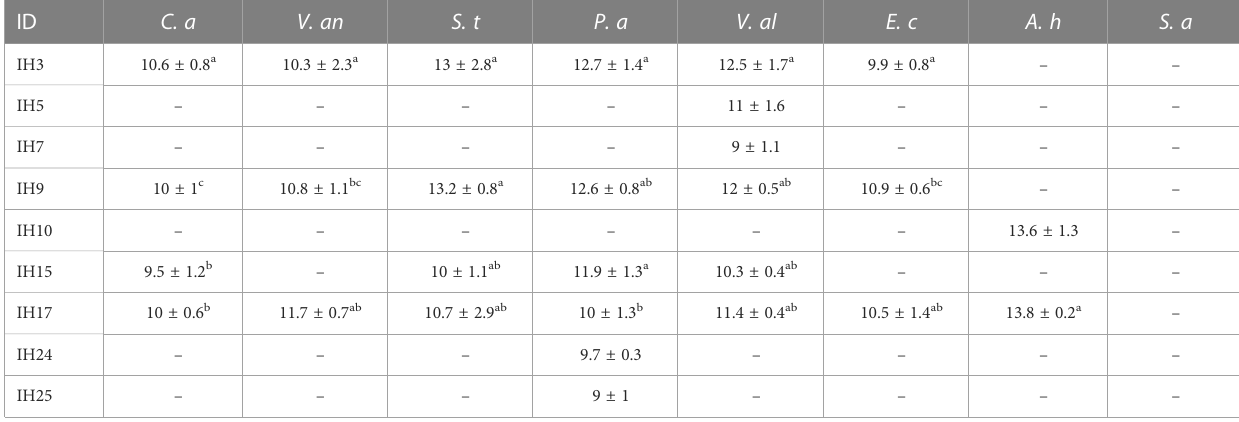
TABLE 2 Antimicrobial activity of Ulva ohnoi -associated bacteria against pathogenic strains